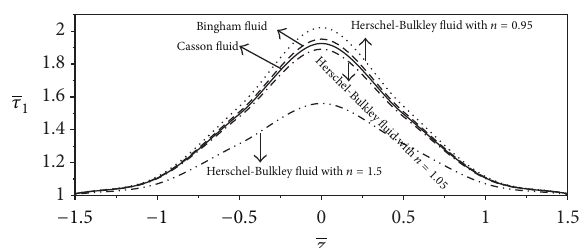
Figure 5: Variations of skin friction 𝜏 1 with stenosis height 𝑎 for different values of yield stress 𝜏 𝑐 .